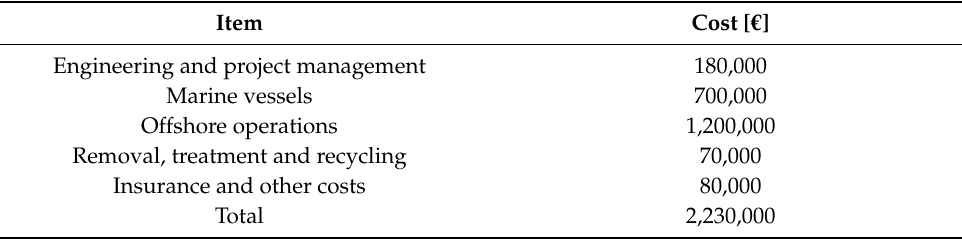
Table 7. Costs inventory according to ENI S.p.A. decommissioning project